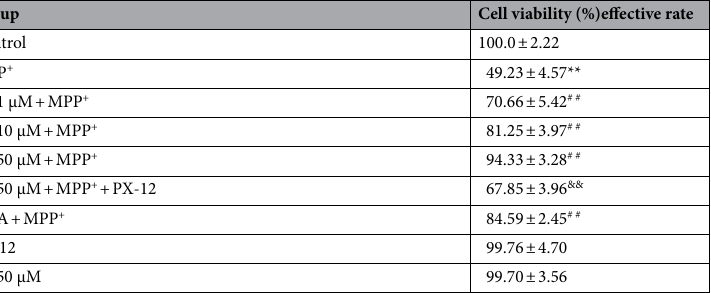
Table 1. Protective effect of Schisanhenol on viability in MPP + -treated SH-SY5Y cells via Trx1. SH-SY5Y cells were pre-incubated with Sal (1 µM, 10 µM, and 50 µM) for 24 h and then were exposed to MPP + (500 μΜ) for 48 h. Cell viability was determined by MTT assay. Data were expressed as mean ± SD from six separate experiments, and each experiment was performed in triplicate. ** P < 0.01 vs Control group; ## P < 0.01 vs MPP + group; && P < 0.01 vs Sal 50 μM + MPP +